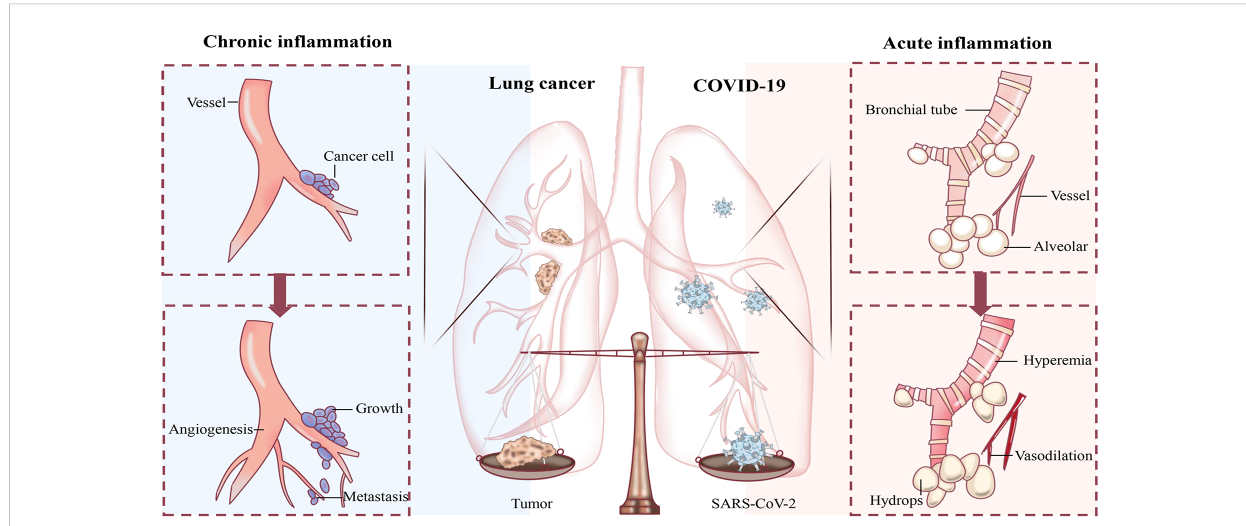
FIGURE 1 Schematic diagram of the in fl uence of in fl ammation on lung cancer and COVID-19. Chronic in fl ammation creates a suitable environment for lung cancer growth, proliferation, metastasis, as well as angiogenesis. The acute in fl ammation in fl icted by COVID-19 dilates the alveolar wall and interstitial blood vessels with increased permeability, causing the accumulation of serous fl uid in the alveolar